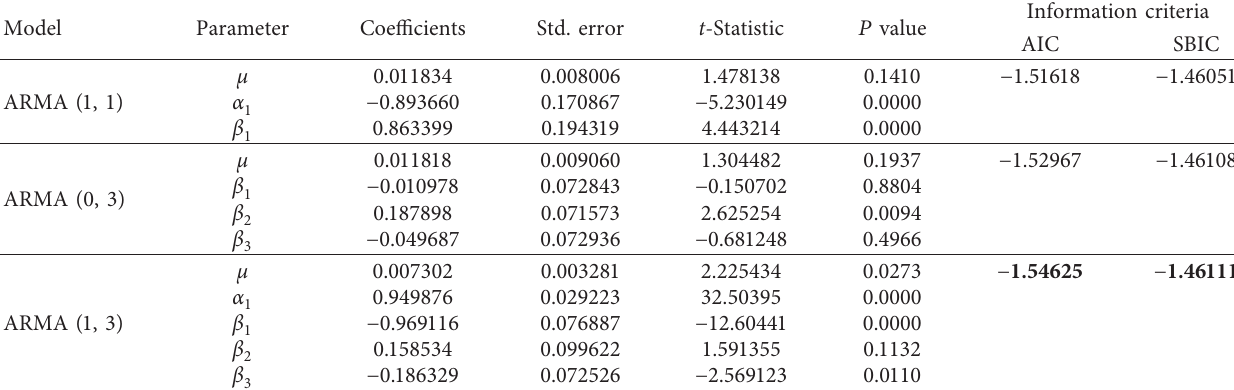
Table 3: Parameter estimates of competing ARMA models with information criteria using MLE.